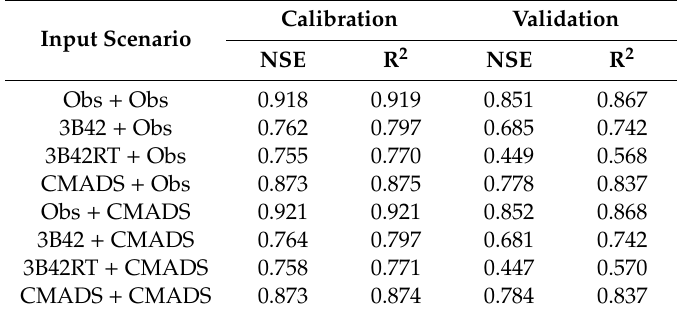
Table 6. Statistical results of the SWAT model during calibration and validation periods driven by different input scenarios in the GRB (input scenarios shown in Table 1).